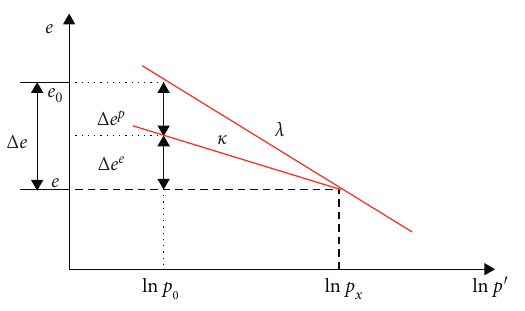
Figure 10: Unloading tests